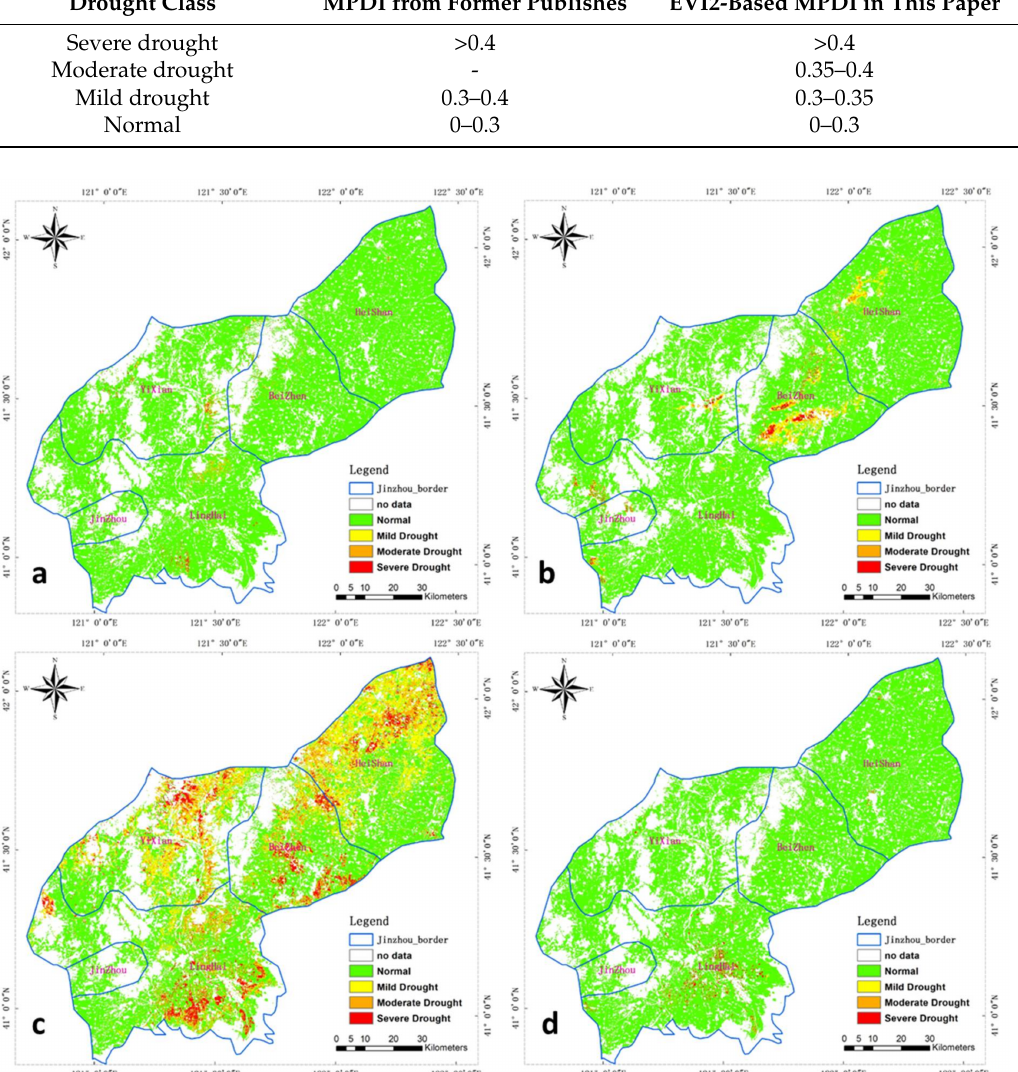
Figure 8. Spatial distribution of drought for EV2-based MPDI in different 2014 crop growing stages: ( a ) 6 June, ( b ) 1 July, ( c ) 2 August and ( d ) 9